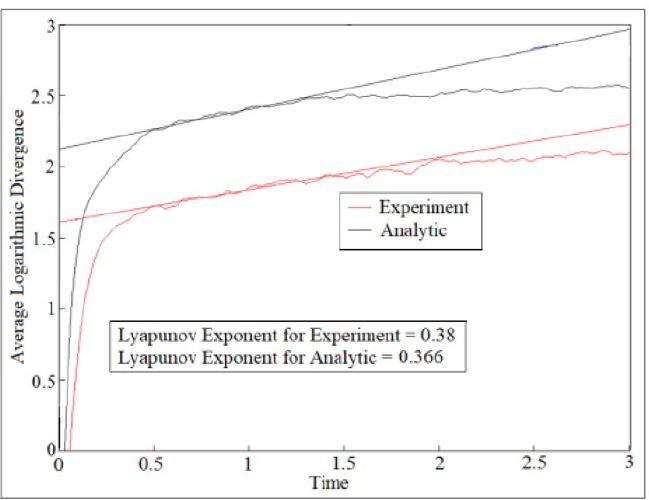
Figure 8. Comparison of Lyapunov exponent parameter.